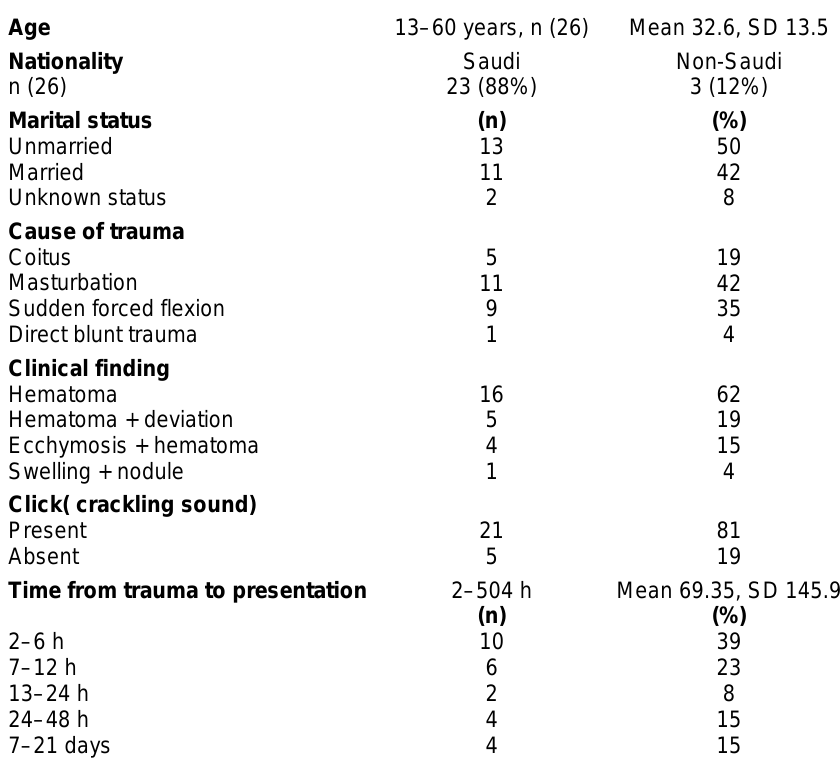
Patient Characteristics and Clinical